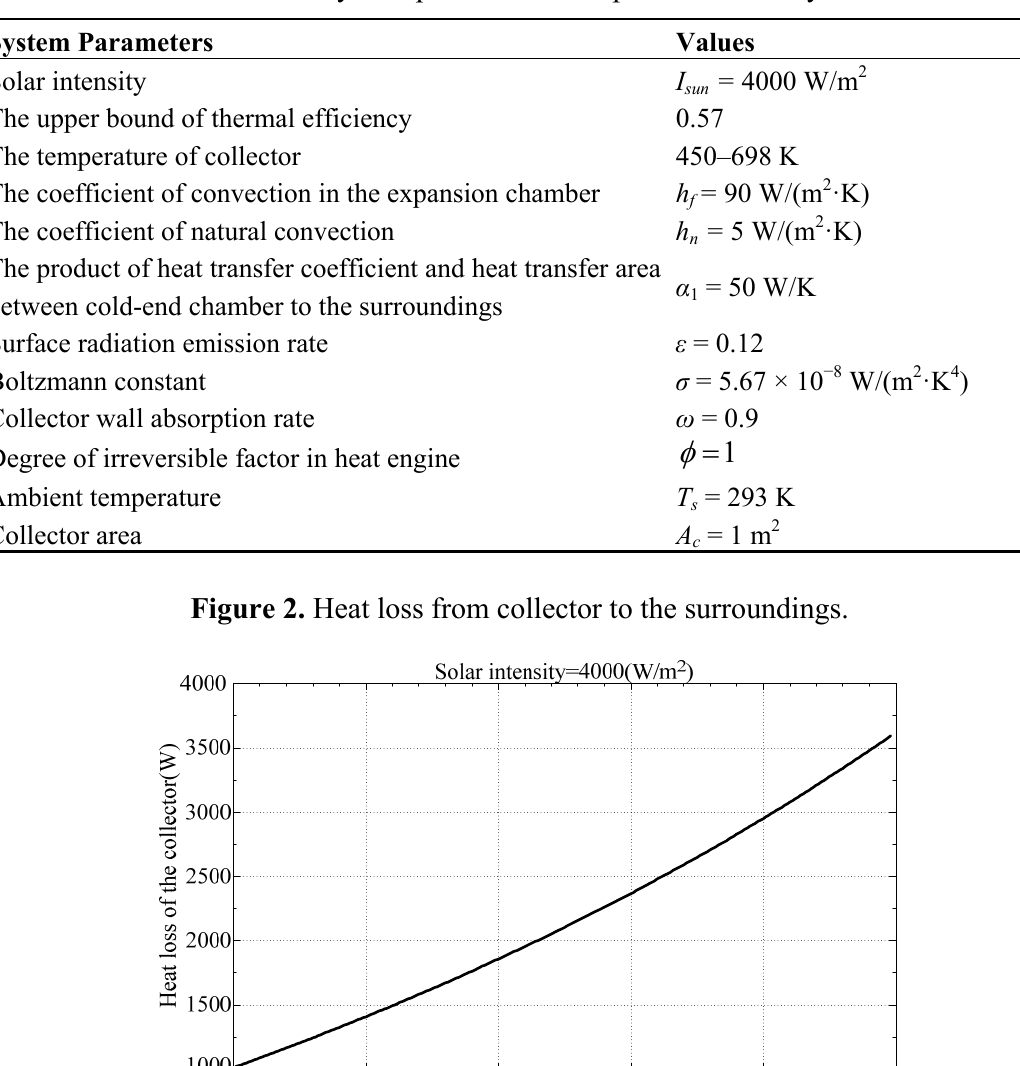
Table 1. System parameters for optimization study.